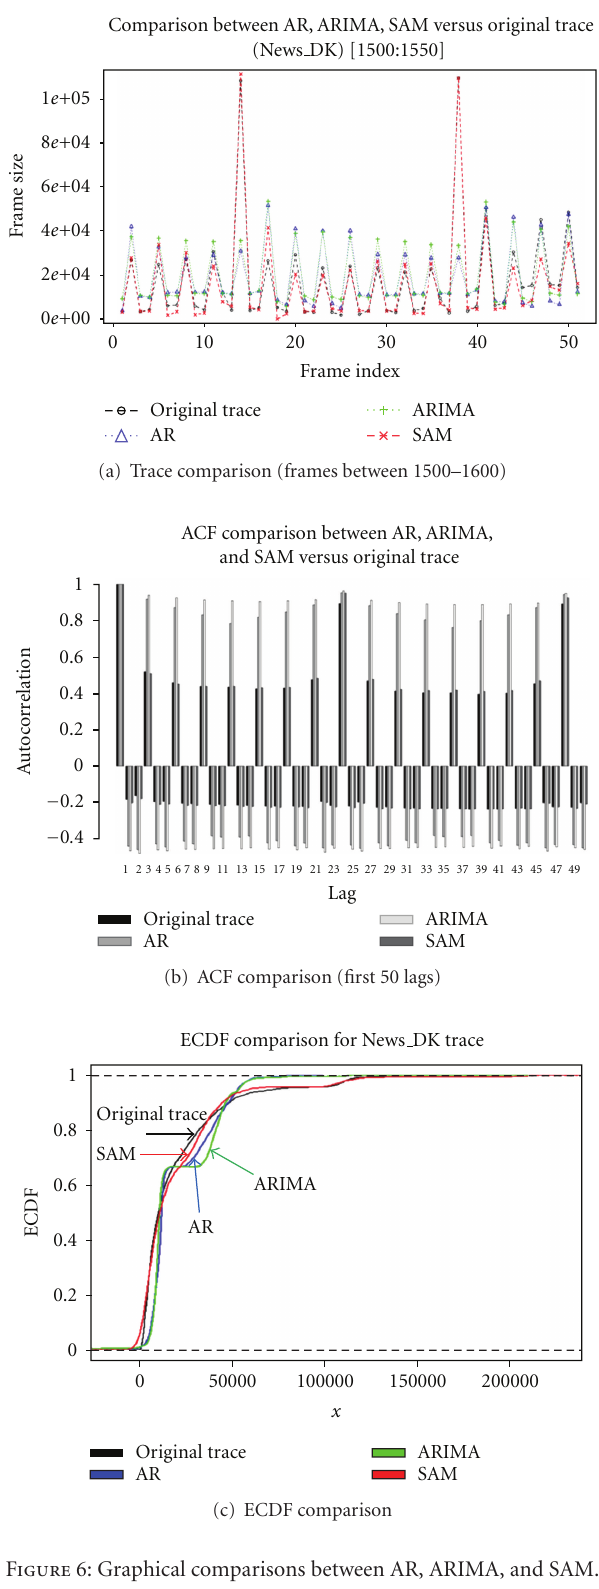
Figure 6: Graphical comparisons between AR, ARIMA, and